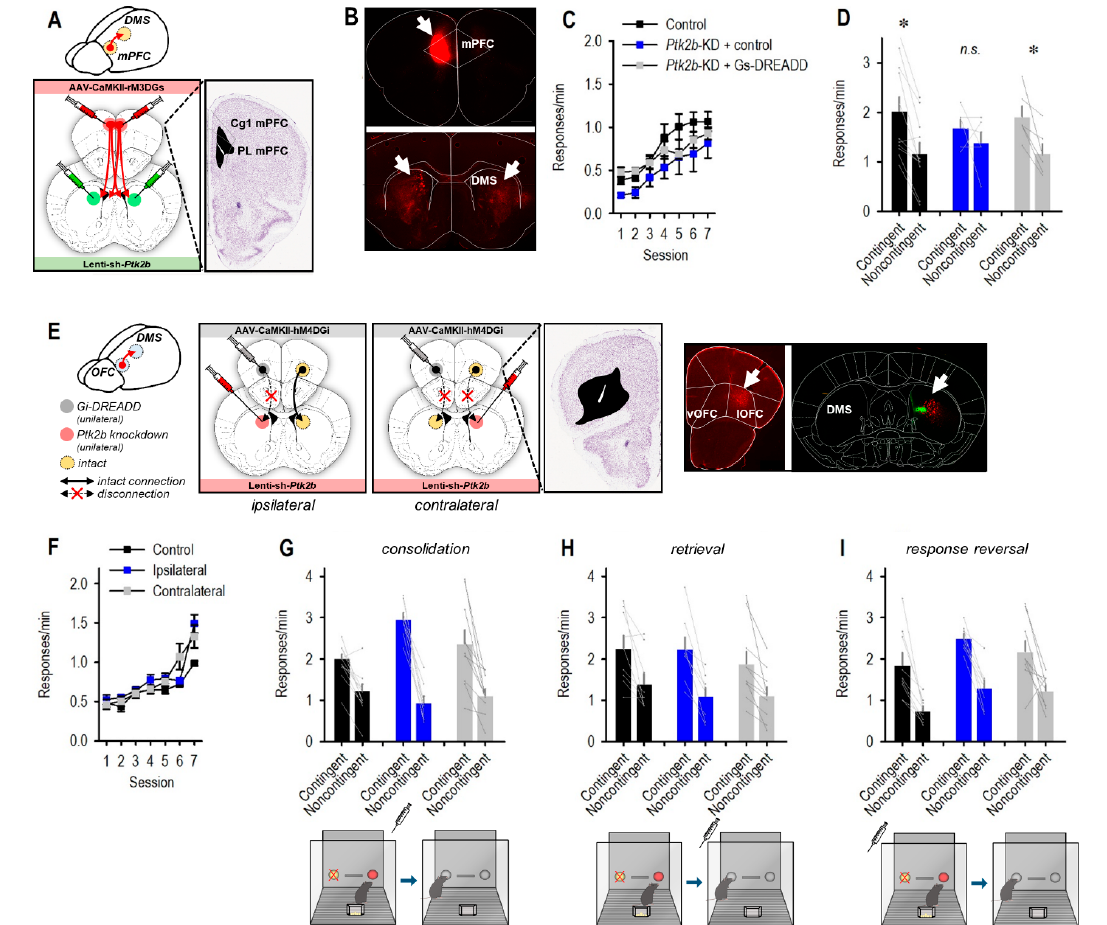
Figure 4. Coordination with the mPFC, but not OFC, in striatal Pyk2-dependent flexible behavior. ( A ) Pyk2 was silenced in the DMS as in Figure 3. Simultaneously, DREADDs-expressing viral vectors were placed in the mPFC, primarily prelimbic cortex (PL). Large and small viral vector spread is represented. ( B ) This experimental design was motivated by evidence that the mPFC (within the white lines) sends monosynaptic projections to the ipsilateral and contralateral DMS. Viral vector placement in the ipsilateral mPFC at the top, with bilateral terminals at the bottom (arrows). ( C ) Response acquisition in the absence of CNO did not differ between groups. Mice with control viral vectors in the DMS and either a control viral vector or a Gs-DREADD-expressing viral vector in the mPFC (and a control viral vector in the DMS) did not differ and were combined into a single control group. ( D ) The DREADD ligand CNO was delivered prior to the period when pellets were delivered noncontingently. Mice were tested in the probe test, drug free, the following day. Control mice inhibited a behavior that was not reinforced (noncontingent condition), while Ptk2b knockdown obstructed response flexibility, as in Figure 3. Simultaneous stimulation of the mPFC via Gs-coupled DREADDs restored response flexibility ( n = 11 combined control group, n = 6 DREADD + Ptk2b knockdown, n = 6 control viral vector + Ptk2b knockdown). ( E ) The OFC and DMS are connected via unidirectional projections that are largely ipsilateral, lending the next experiment to a disconnection experimental design in which Pyk2 is silenced in the DMS of one hemisphere and Gi-DREADDs are placed in the OFC of one hemisphere. The contralateral condition tests whether Pyk2-dependent action selection requires inputs from the OFC. Representative OFC infusion sites and spread are adjacent. At right : Unilateral infusion of an mCherry-expressing viral vector in the OFC results in detectable terminals in the ipsilateral DMS (red), corresponding with the site of Ptk2b knockdown (green), but not the contralateral DMS. ( F ) Mice were trained to nose poke for food in the absence of CNO. ( G ) CNO was delivered at multiple time points, represented by the cartoons below each graph, ultimately revealing no effects on memory consolidation, ( H ) memory retrieval, or ( I ) a response reversal. n = 9 control, n = 8 ipsilateral, n = 10 contralateral, * p < 0.05. Cg1, cingulate cortex, area 1. DMS, dorsomedial striatum. KD, knockdown. lOFC, lateral orbitofrontal cortex. mPFC, medial prefrontal cortex. NS, non-significant. PL, prelimbic cortex. vOFC, ventral orbitofrontal cortex. Error bars represent SEM. Line connecting bars represent individual